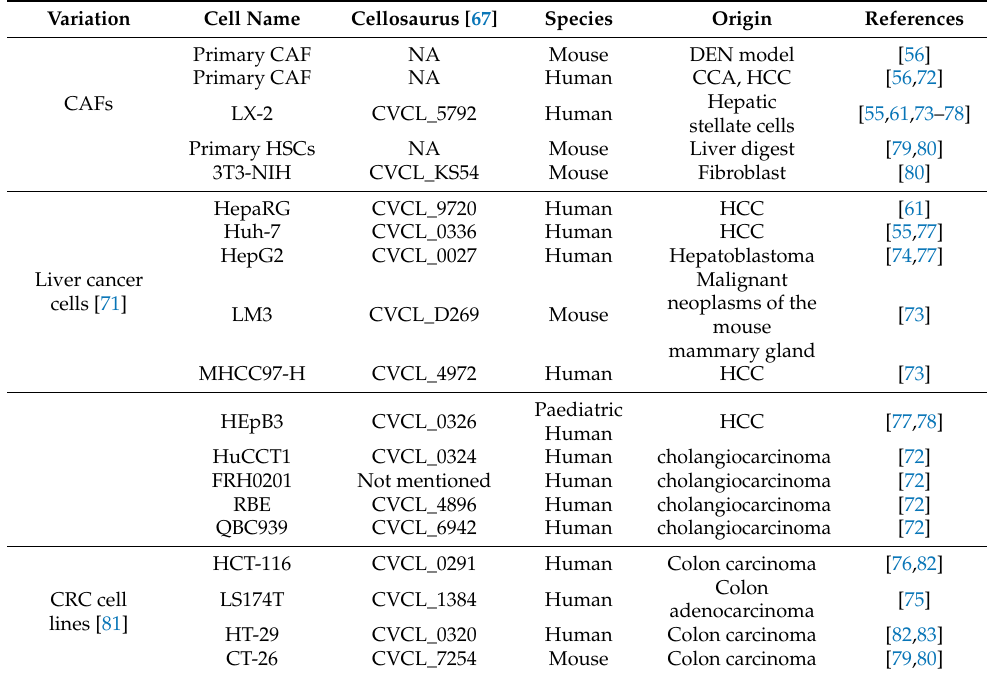
Table 1. Sources for CAFs and cancer cells used for in vitro modelling of primary and secondary liver